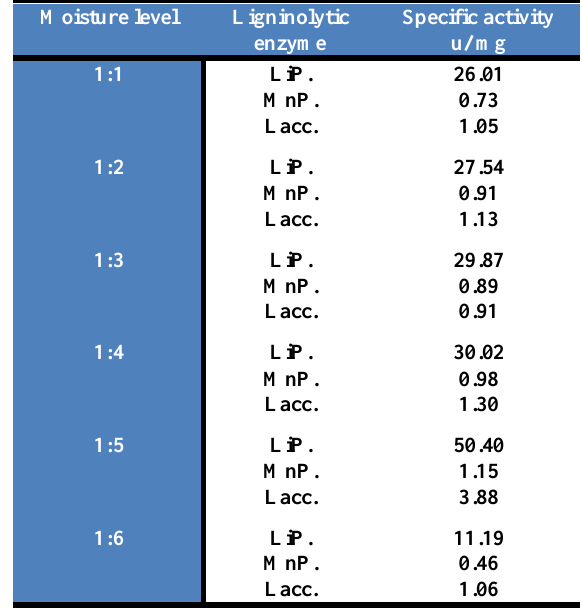
Table, 6: Effect of Moisture level and enzymes production in specific activity (U/mg).